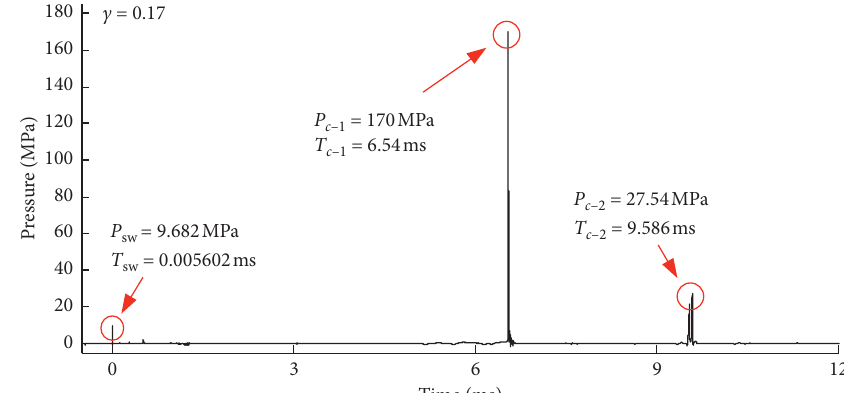
Figure 27: Pressure-time diagram of the first and second cycles of the spark-generated bubble load for c � 0.17.